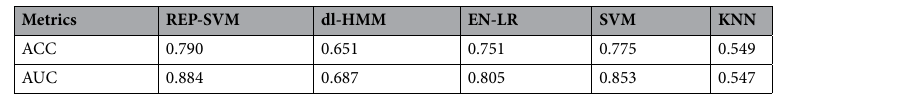
Table 1. ACC & AUC versus percentage of missing values, where all metrics are obtained via LOO CV on the 27 patients with seven time points in Dataset1.